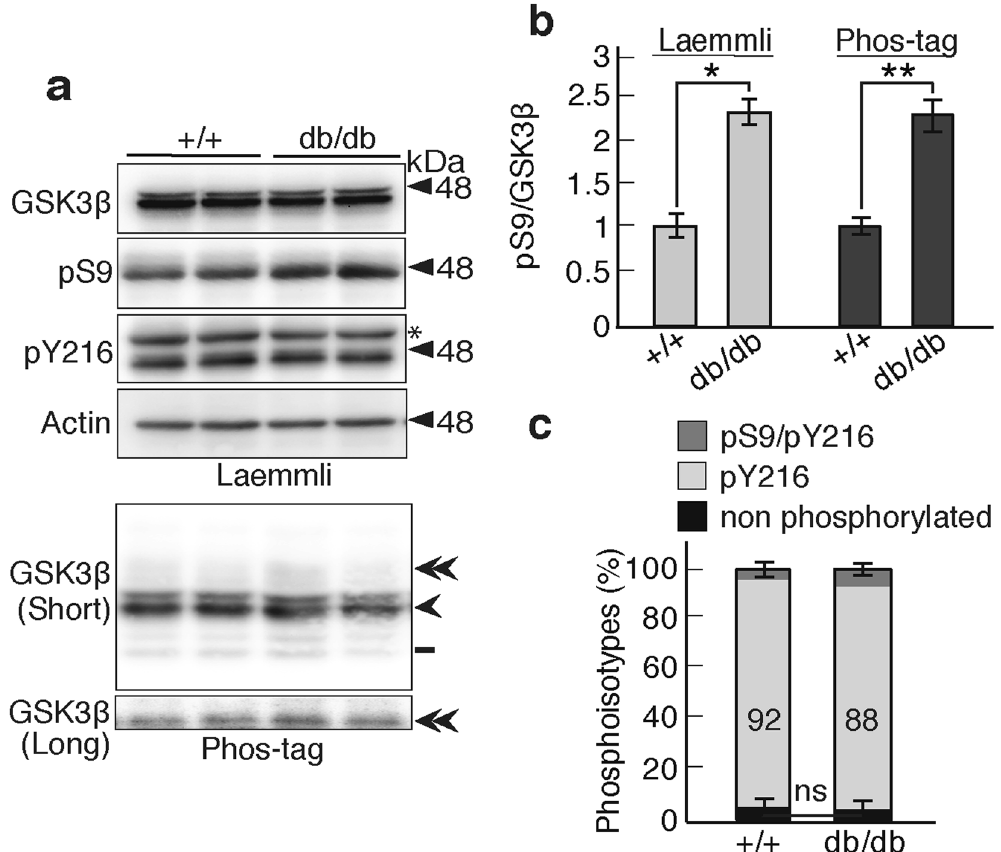
Figure 8. GSK3 β phosphoisotypes in the brains of db/db mice. ( a ) GSK3 β , phospho-Ser9 (pS9), phospho- Tyr216 (pY216) and actin in the cerebral cortex of wild type mice ( + / + , left two lanes) or db/db (right two lanes) were examined using the Laemmli’s SDS-PAGE and phosphorylation of GSK3 β by Phos-tag method. ( b ) The ratio of phospho-Ser9 to total GSK3 β in wild type ( + / + ) and db/db mice. The left two bars show the data obtained from the anti-phospho-Ser9 immunoblot after Laemmli’s SDS-PAGE and the right two bars show the data obtained with Phos-tag SDS-PAGE. The ratio is expressed relative to that in the wild type ( + / + ) mouse brain (means ± s.e.m. n = 4, * p < 0.05, ** p < 0.01, Student’s t test). ( c ) The percentages of the GSK3 β phosphoisotypes on Phos-tag SDS PAGE were quantified: dark gray, phospho-Ser9/Tyr216; light gray, phospho-Tyr216; and black, nonphosphorylated GSK3 β . The percentages of phospho-Tyr216 are indicated (means ± s.e.m. n = 4, ns, not significant). Uncropped immunoblots of GSK3 β , pS9, pY216 and actin after Laemmli’s SDS-PAGE and GSK3 β after Phos-tag SDS-PAGE are provided in Supplementary Fig.